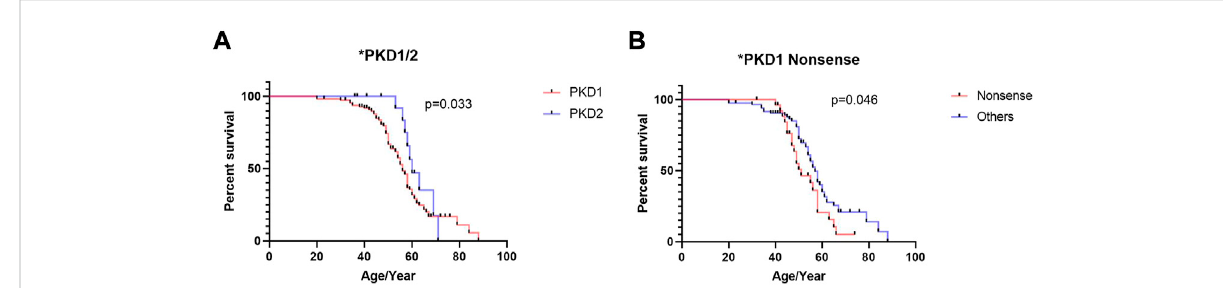
FIGURE 2 Kaplan – Meier survival analysis of ADPKD patients strati fi ed by genotypes and mutation types. (A) Comparison of patients with PKD1 gene mutation and PKD2 gene mutation (B) Comparison of patients with PKD1 gene nonsense mutation and PKD1 gene other mutation. The end-point event was the start of regular renal replacement